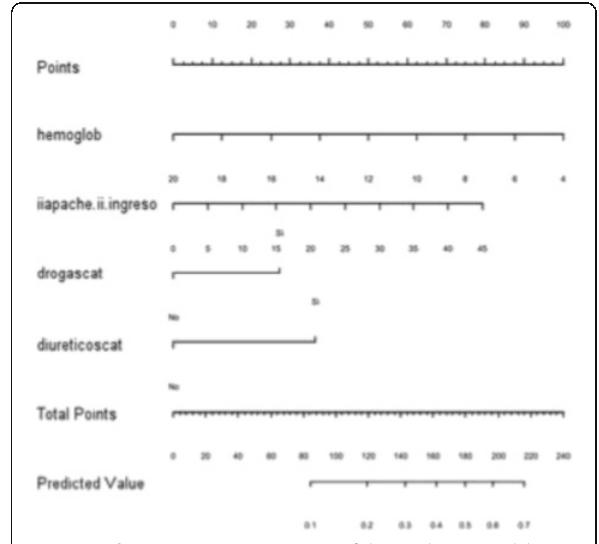
Fig. 127 (abstract A324). Nomogram of the predictive